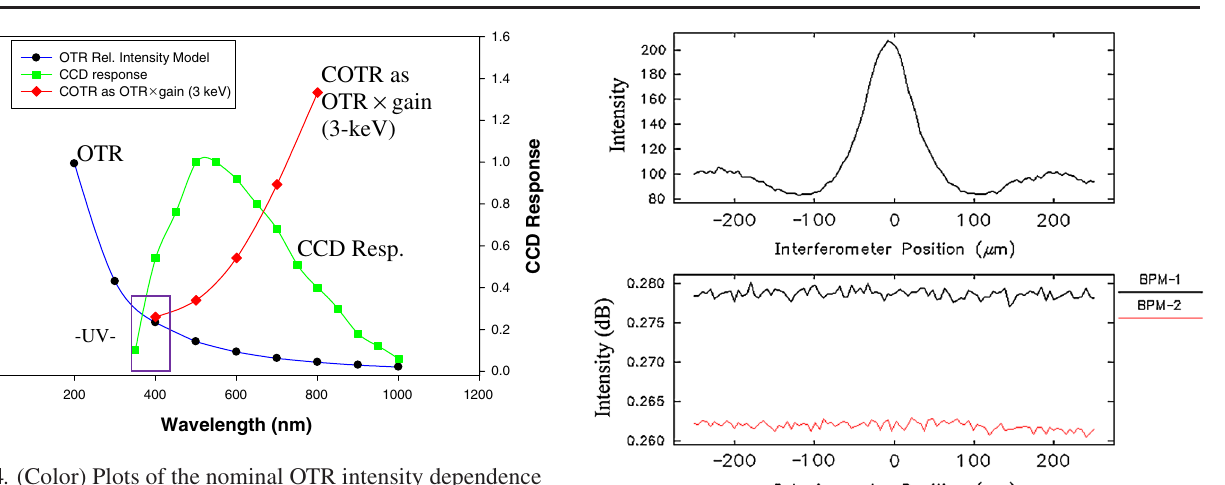
FIG. 14. (Color) Plots of the nominal OTR intensity dependence on 1 =(cid:2) 2 , the COTR intensity using the calculated gain factor at LCLS for a 3-keV slice energy spread [8], and the nominal CCD camera relative response. The small violet rectangle indicates the 400 nm (cid:2) 40 nm BPF regime next to the